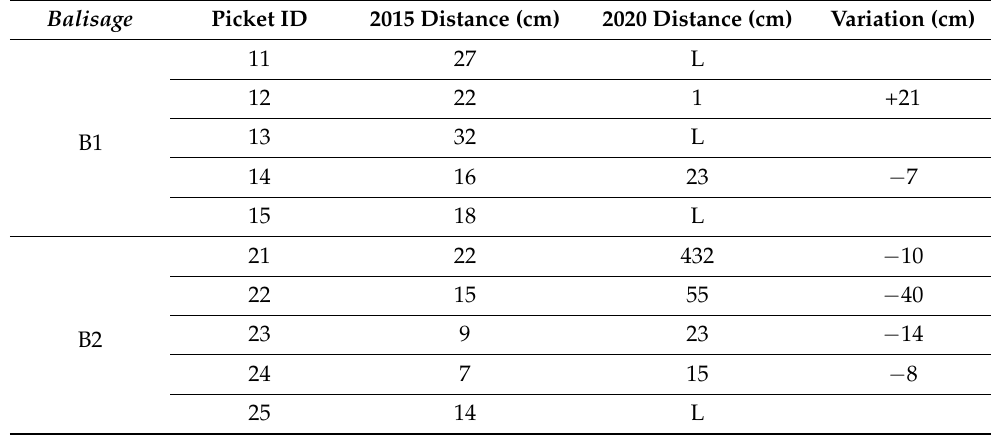
Table 5. Distance (cm) between each of the five pickets per balisage system (B1–B5) and the